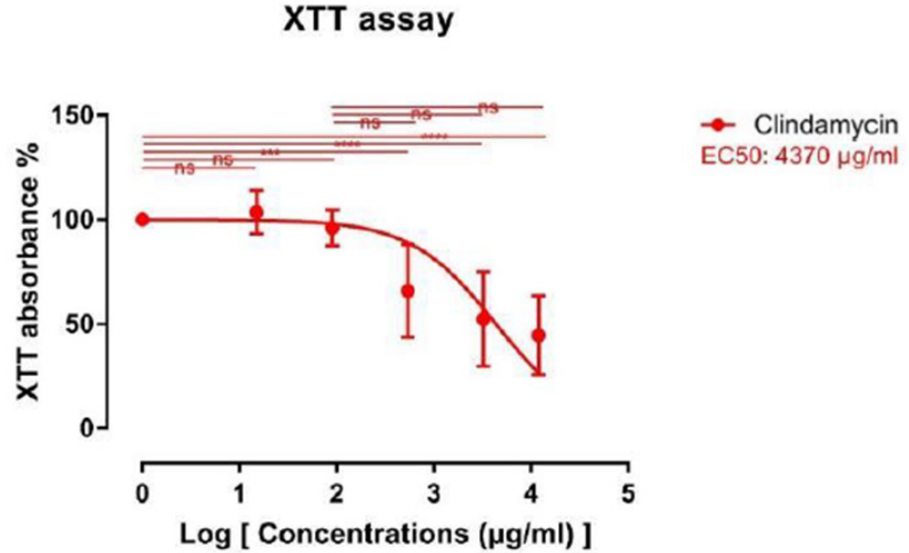
Figure 3. Sigmoidal dose-response curve for XTT assay. Data are shown as mean ± standard deviation. Asterix denotes statistically significant difference vs. the control group (ns = not significant; *** = p < 0.001; **** = p < 0.0001). ns means non-significant. EC50 characterizes the concentration leading to a 50% reduction.